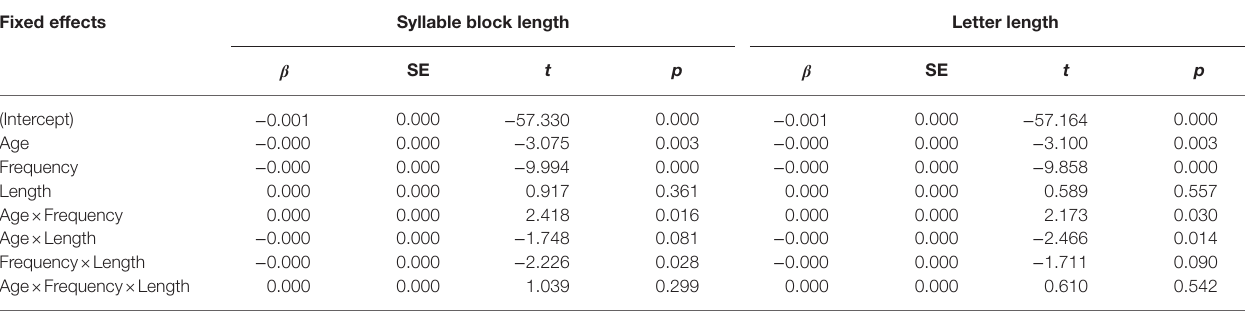
TABLE 9 | Estimates of fixed effects in reading latency: age × frequency × length on words. Fixed